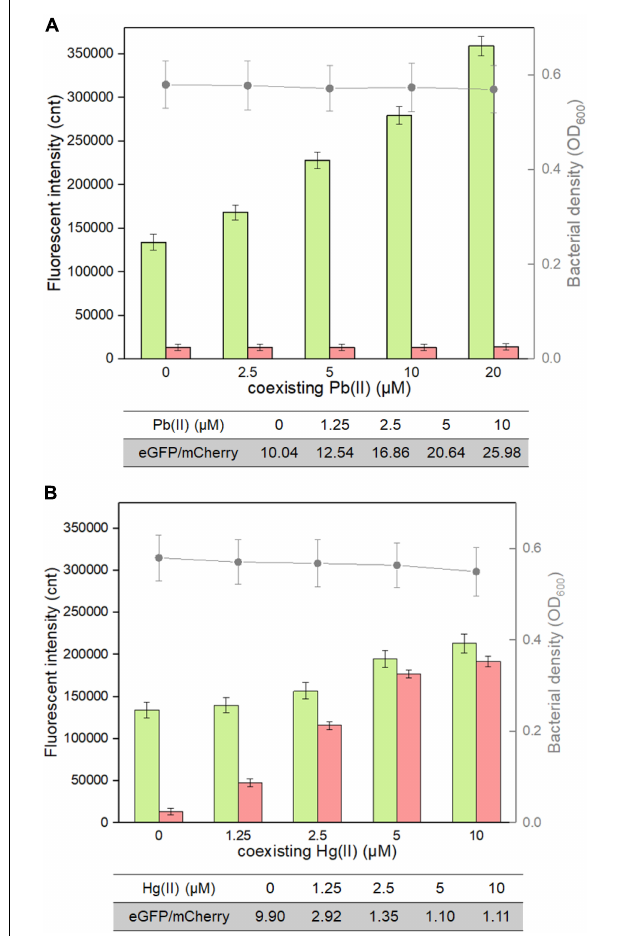
FIGURE 6 | Influence of non-responsive metal ions on the response of the dual-sensing biosensor toward Cd(II). Double-color fluorescence derived from TOP10/pCadC-G-CadR-R exposed with 5 µ M Cd(II) in the presence of various non-responsive metal ions. After a 12-h incubation at 37 ◦ C, bacterial cell density (OD 600 ) was measured (point line diagram, right-Y scale) using a microplate reader, and both eGFP (green bars) and mCherry (red bars) fluorescent intensities were determined using a fluorescence spectrophotometer (bar chart, left-Y scale). The fluorescent signal was indicated as a fluorescence count value (unit = cnt), and fluorescence intensity values were normalized using the absorbance at 600 nm. The data values shown for each metal exposure group were obtained by subtracting the control values (with no metal exposure) from the experimental values. Results are the average of at least three independent experiments performed in triplicate.